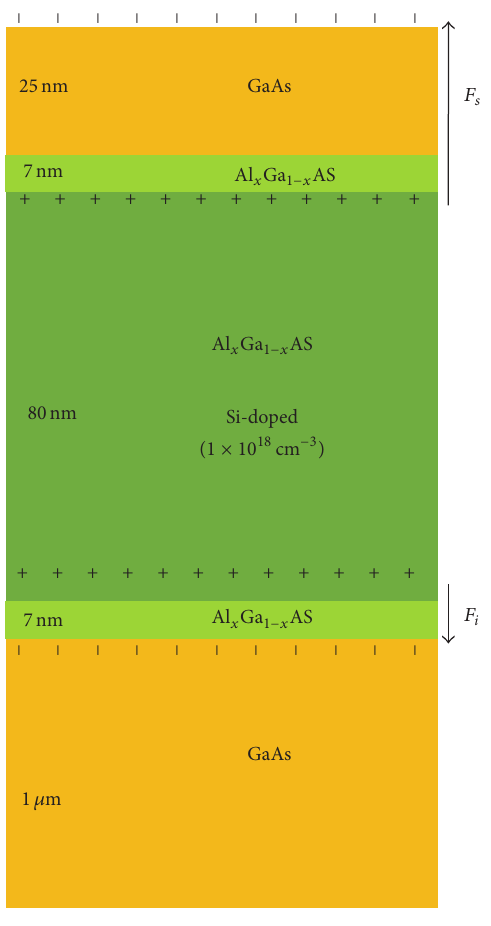
Figure 1: Schematic diagram of semiconductor layers in the het- erostructures. 𝐹 𝑠 and 𝐹 𝑖 label the surface and internal electric field region,